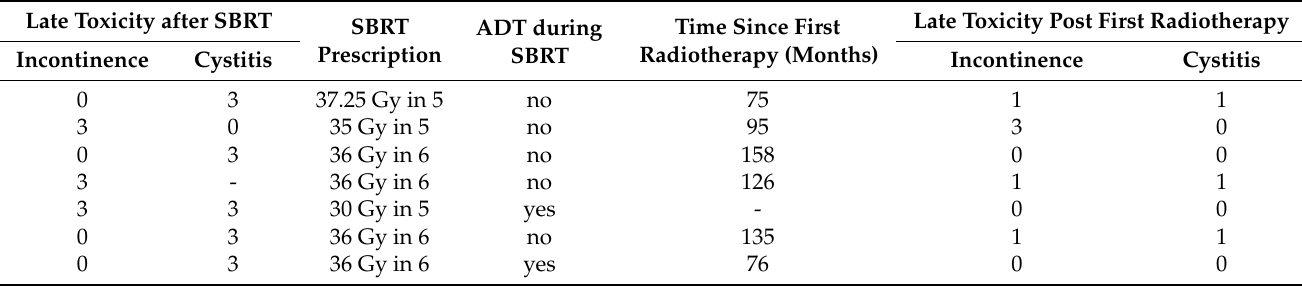
Table 4. Main characteristics of the patients with a grade 3 urinary